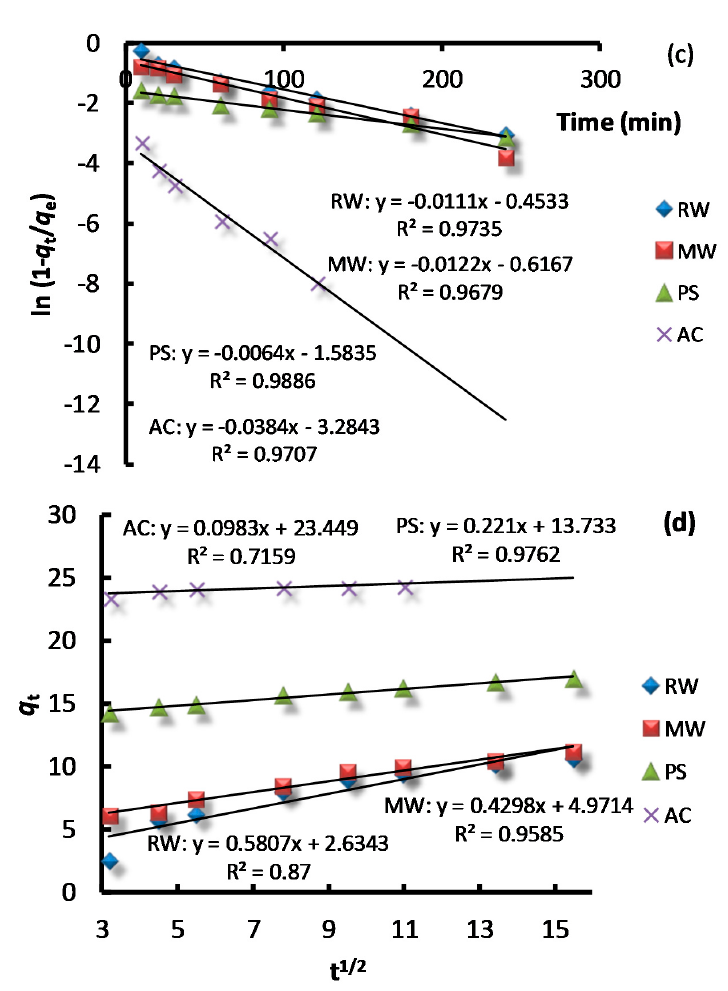
Figure 4. Pseudo first order kinetic ( a ) and pseudo second order kinetic models ( b ); Film diffusion ( c ) and intraparticle diffusion models ( d ).